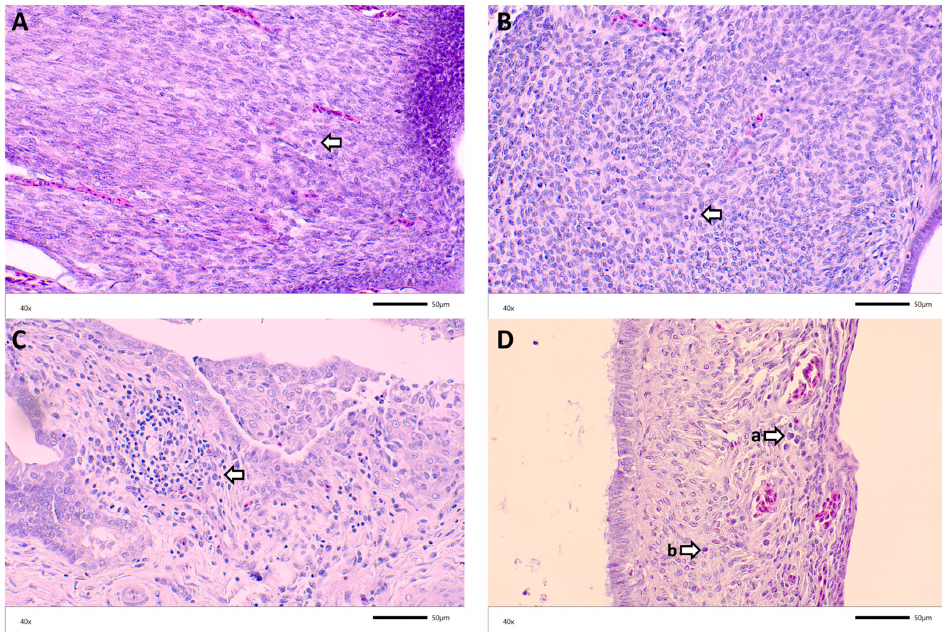
Figure 4. Representative histological findings from DMV/1639/11 challenge: Arrows point to ( A ) minimal inflammatory infiltrates in oviduct of a 2-week-old bird challenged with DMV at 7 DOA; ( B ) lymphocytes in the oviduct of a 5-week-old bird challenged with M41 at 7 DOA; ( C ) lymphoplasmacytic inflammation in the oviduct of a 12-week-old bird challenged with DMV at 3 DOA; (( D ), (a)) plasma cells and (( D ), (b)) lymphocytes in the oviduct of a 13-week-old bird challenged with M41 at 7 DOA.